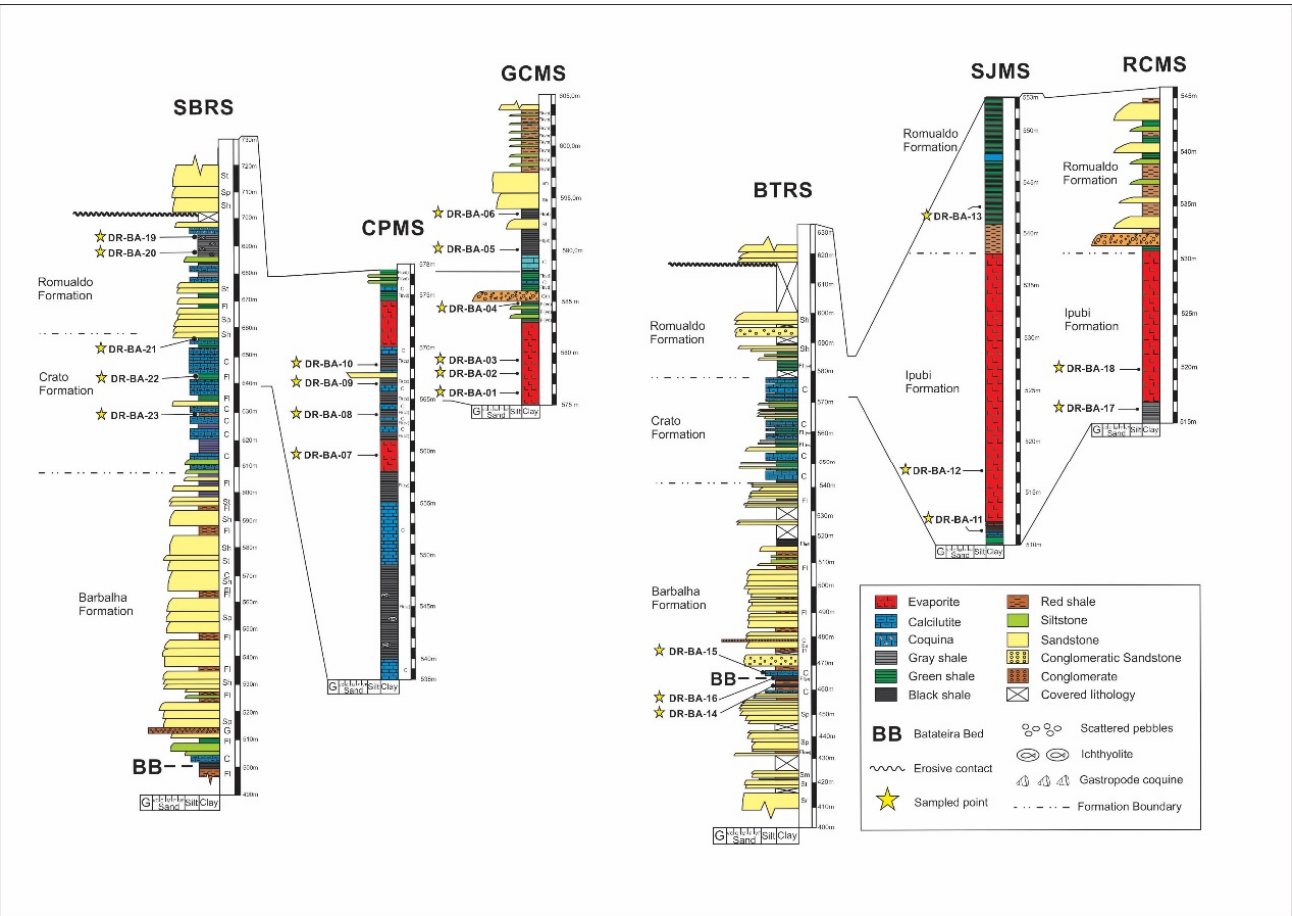
Figure 2. Columnar sections of the Santana Group formations, including facies, thickness, position of collected samples, and lateral correlation. The abbreviation means the name of the sections analyzed in this research: Batateira River (BTRS), Sobradinho River (SBRS), Rancharia Mine (RCMS), São Jorge Mine (SJMS), Gesso Chaves Mine (GCMS), and Conceição Preta Mine (CPMS).